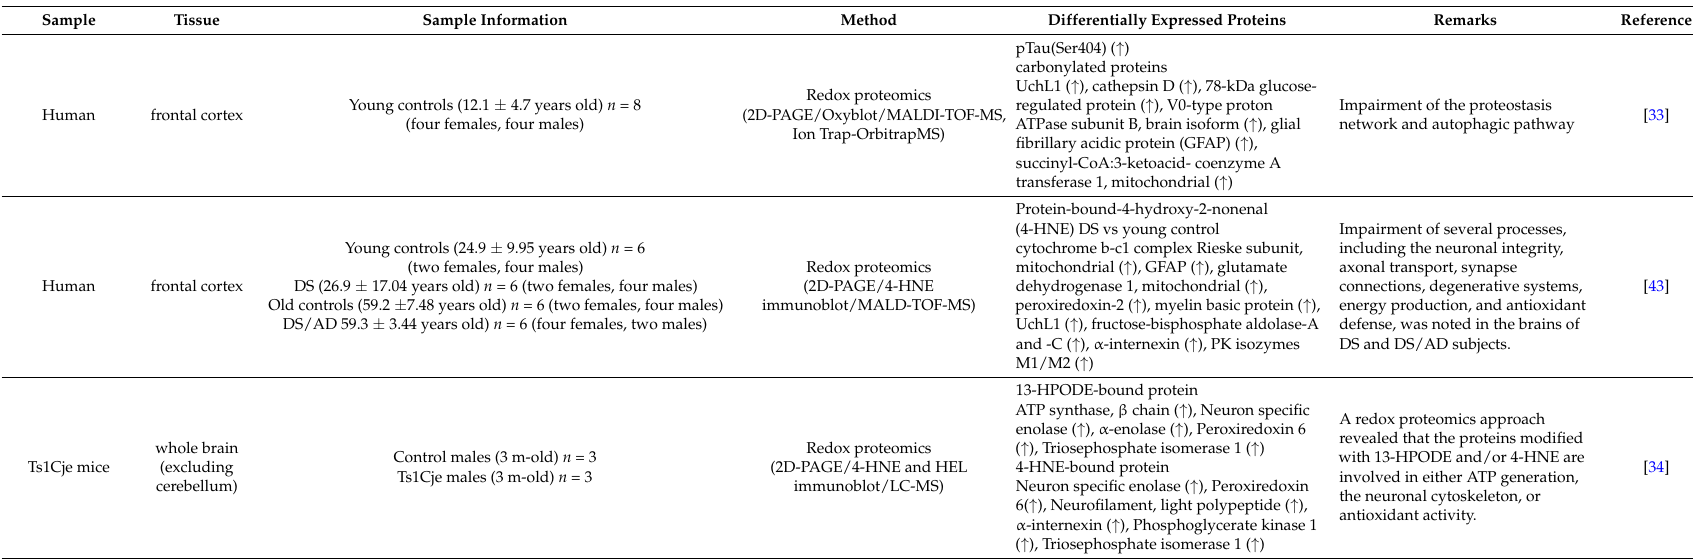
Table 3. A comparative redox proteomic analysis of the brain with